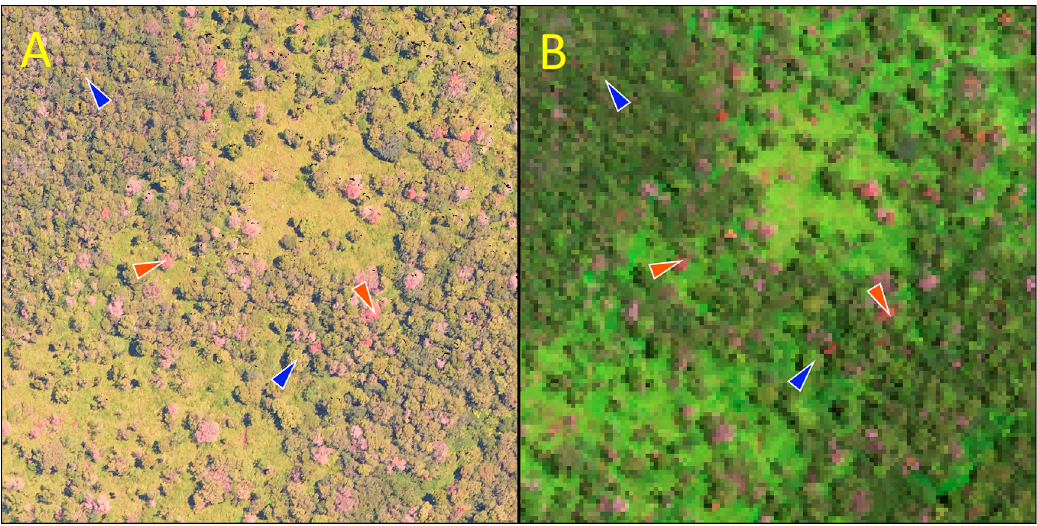
Figure 2. Example images from the Carnegie Airborne Observatory: ( A ) high-resolution digital color camera and ( B ) visible-to-shortwave infrared (VSWIR) imaging spectrometer showing suspected ROD-infected brown-state crowns and green crowns. Red arrows point to representative brown-state trees and blue arrows point to healthy green trees.